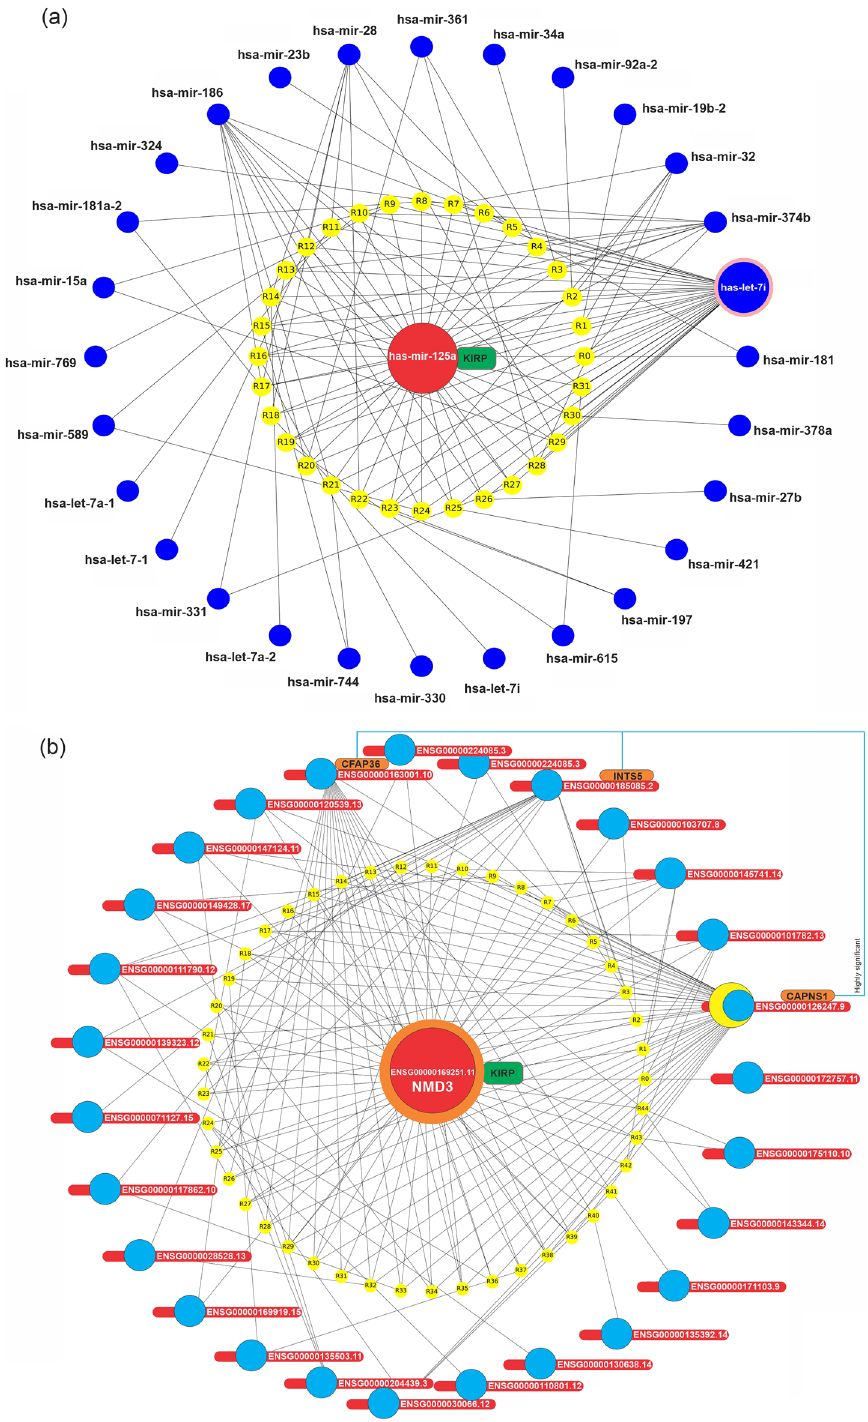
Figure 8. The relationship and specification of the miRNAs and mRNAs are based on the KIRP association rules. Graph network of ( a ) has-miR-125a (with support > 1.26) related association rules, in which the identified miRNA, its rules, and miRNAs were presented, in orange, yellow, and blue colors, respectively. ( b ) Graph network of ENSG00000169251.1 related association rules (with support > 0.2 and lift > 1.145), in which ENSG00000169251.1, rules, mRNAs were presented, in red, yellow, and blue colors,